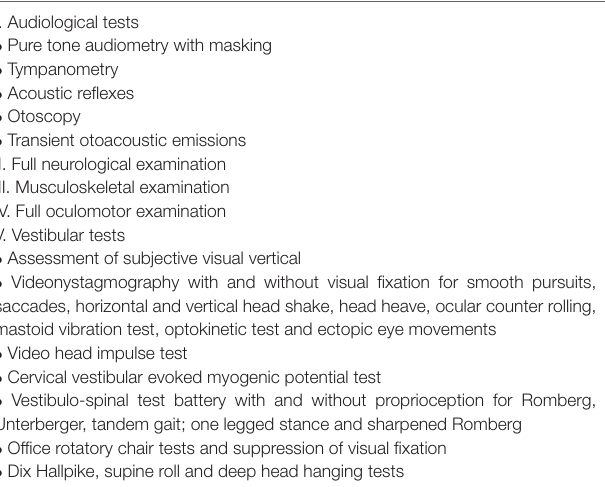
PSCT— Figure 2 ; Group C X linked— Figure 3 , and Group D Multiple— Figure 4